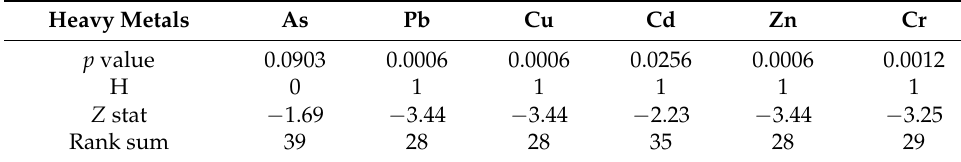
Table 2. The results from the rank sum test with significant level of α = 0.05 between the average content of heavy metals in 2019 and that of 2009 from literature